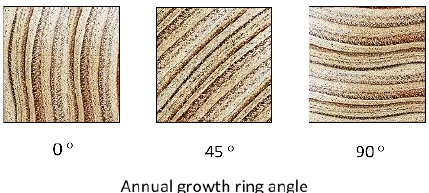
Figure 1. The arrangement of the three general annual growth ring orientations in the cross-section of the samples.